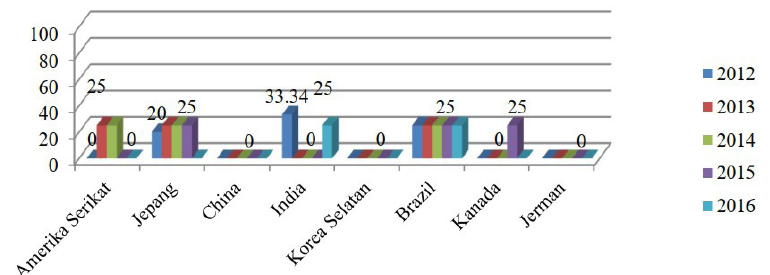
Figure: 2. Frequency Index TBT (%) at Natural Rubber Export (TSNR) to Major Desti - nation Countries